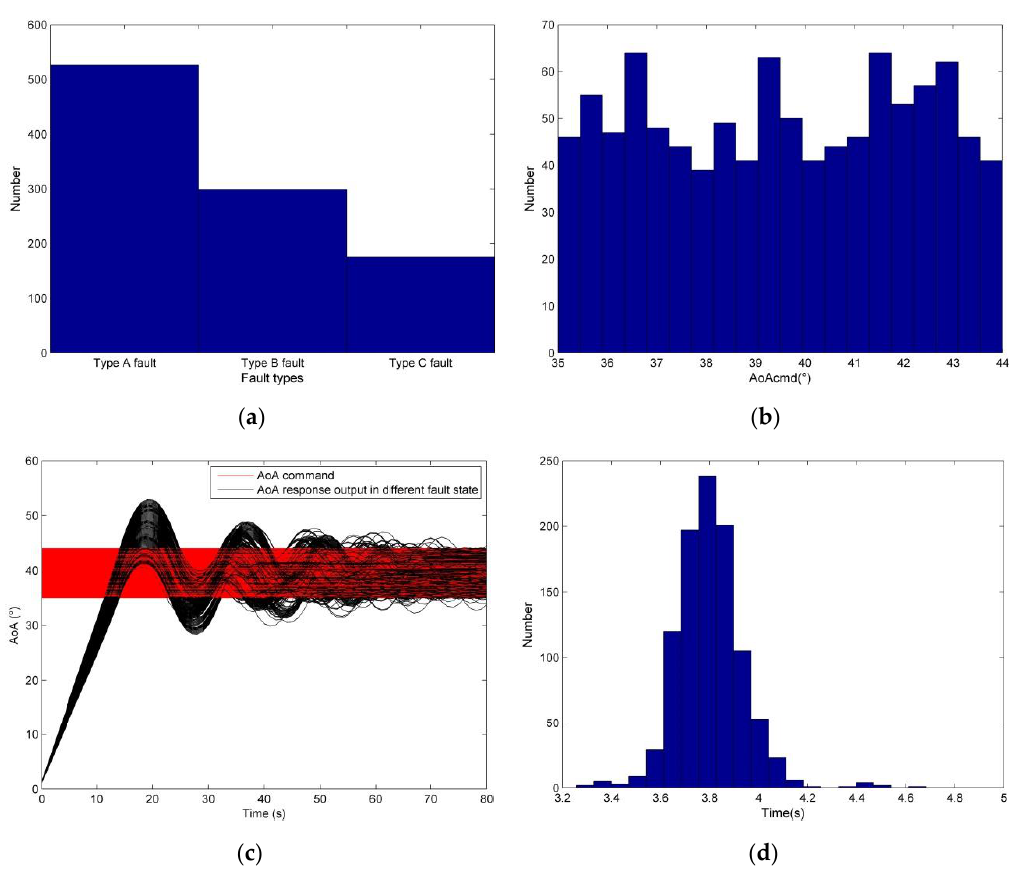
Figure 14. Running time and stability tests of thruster fault detection and control recovery evaluation: ( a ) random fault assignment statistics; ( b ) random AoA command given statistics; ( c ) AoA response output based on the thruster fault detection and control recovery; ( d ) running time statistics for each sample.